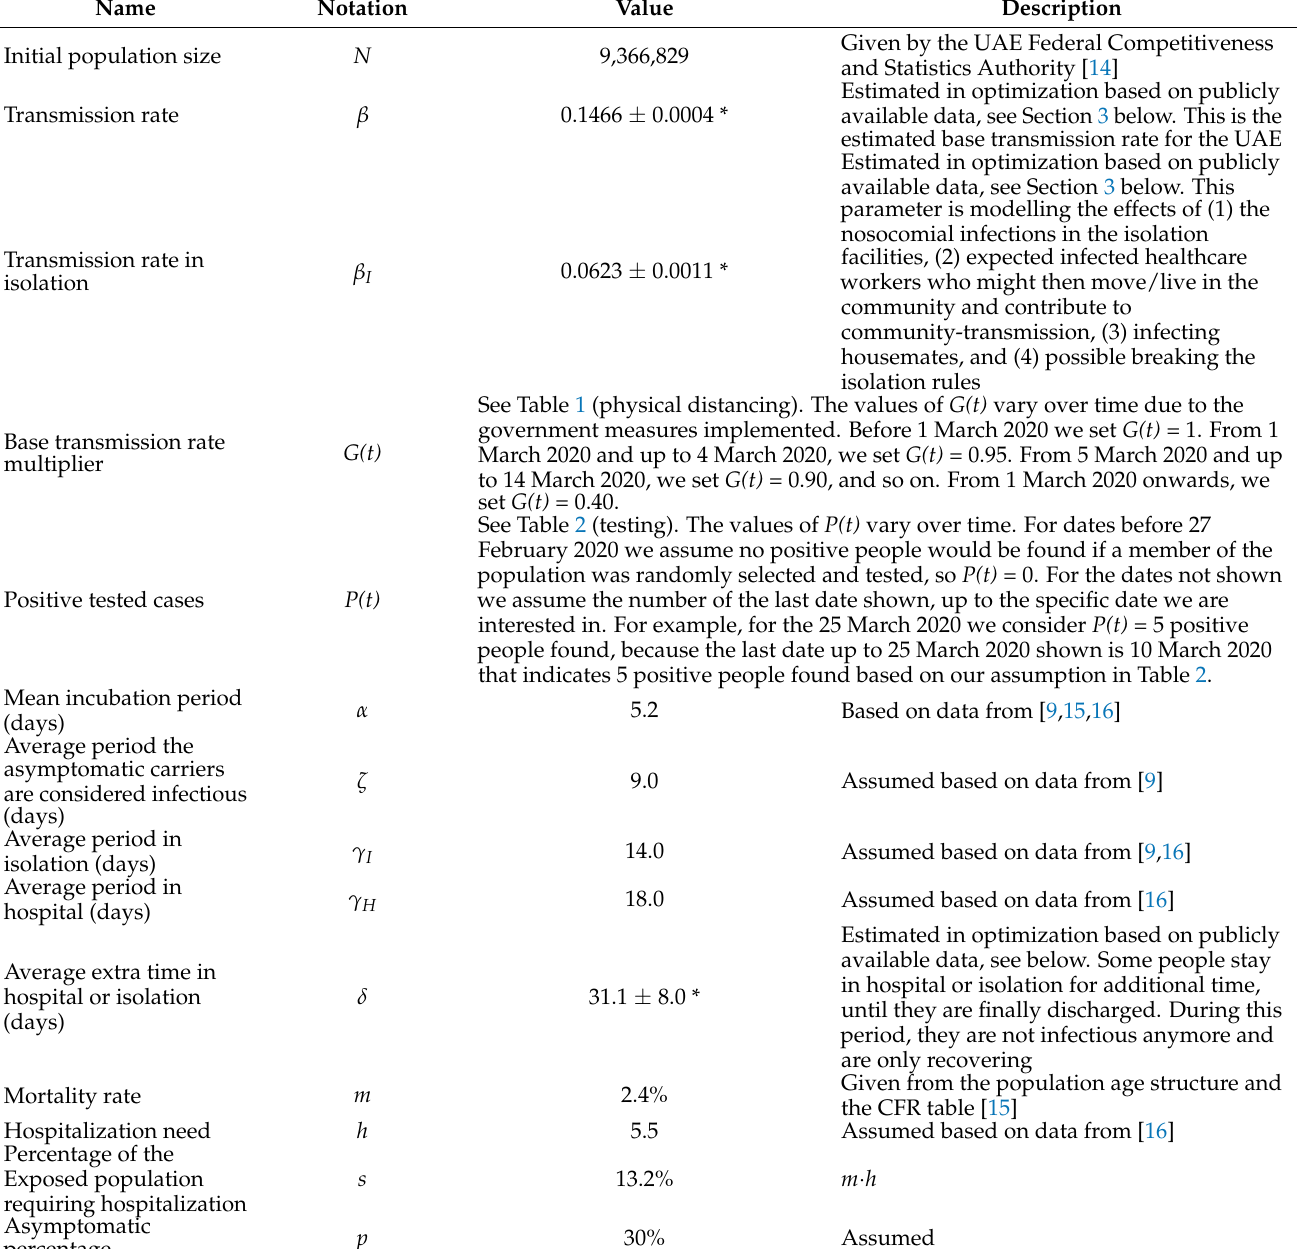
Table 3. The parameters used for the SEAHIR